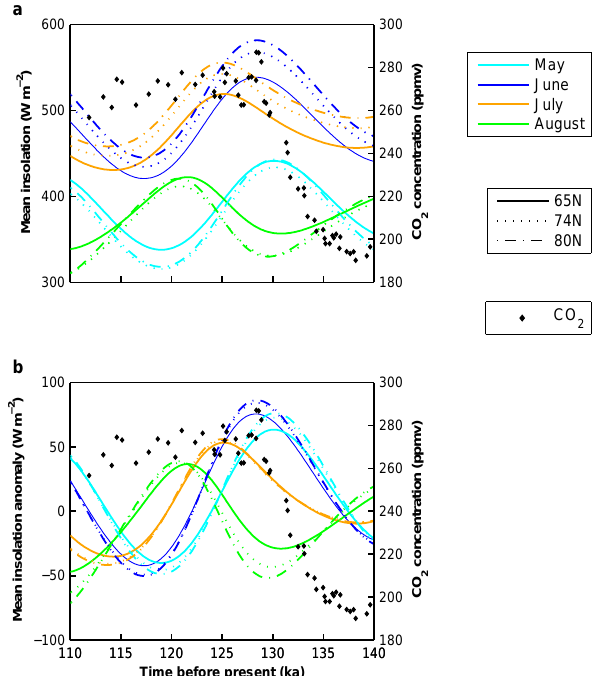
Fig. 2. Time series of LIG (a) insolation and (b) insolation anomaly relative to the pre-industrial period over Greenland for the period 140 to 110ka. Insolation values are calculated using the numeri- cal solution of Laskar et al. (2004) using the Julian calendar. Also overlain is CO 2 concentration (ppmv) from the composite record of L¨uthi et al. (2008) based on data from Petit et al. (1999) and P´epin et al. (2001) for the LIG (they are on the EDC3 gas age scale (Loulergue et al., 2007)). The colours correspond to the following months: May (light blue), June (blue), July (orange) and August (green). Line styles refer to different latitudes over Greenland.